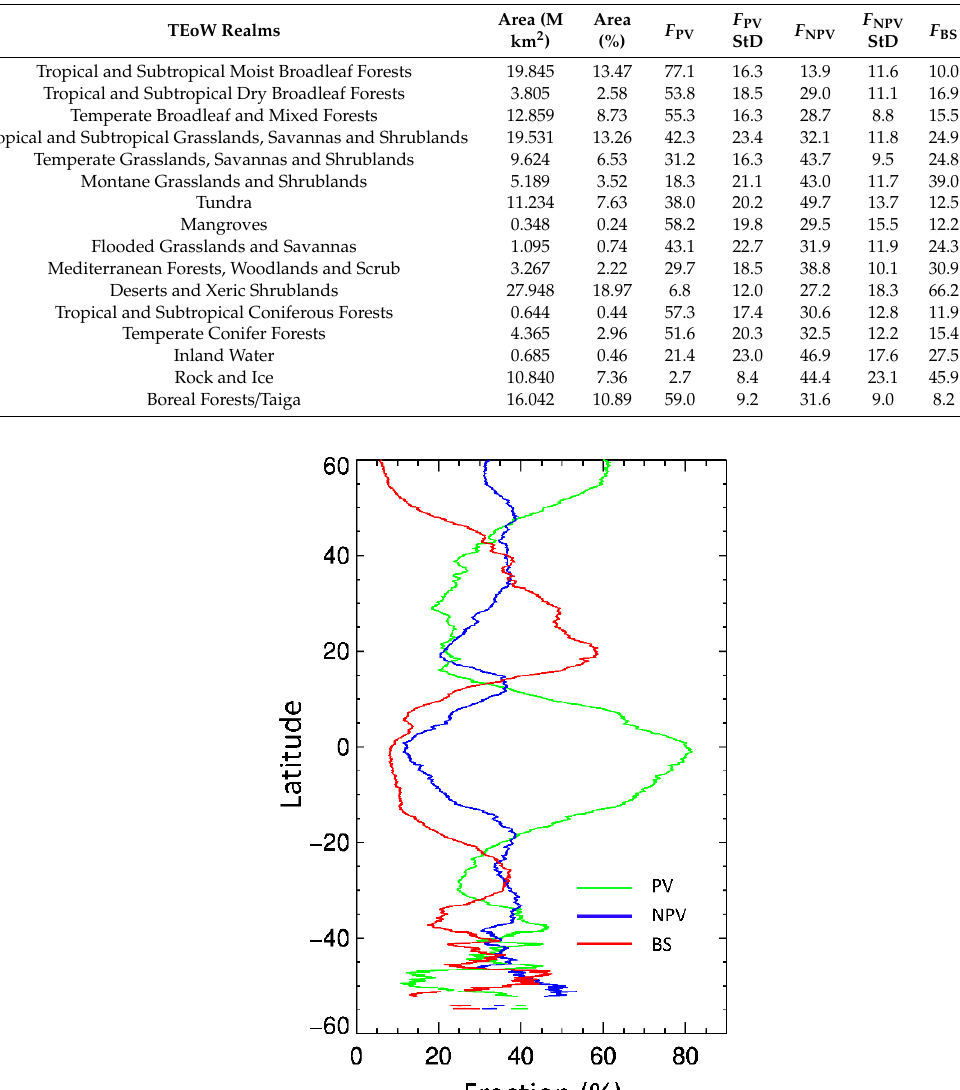
Table 1. Mean and standard deviation of fractional cover (%) from 2001–2018 across the Realms of the Terrestrial Ecoregions of the World (TEoW). Note that overall means do not sum to exactly 100% due to temporal and spatial averaging e ff ects.